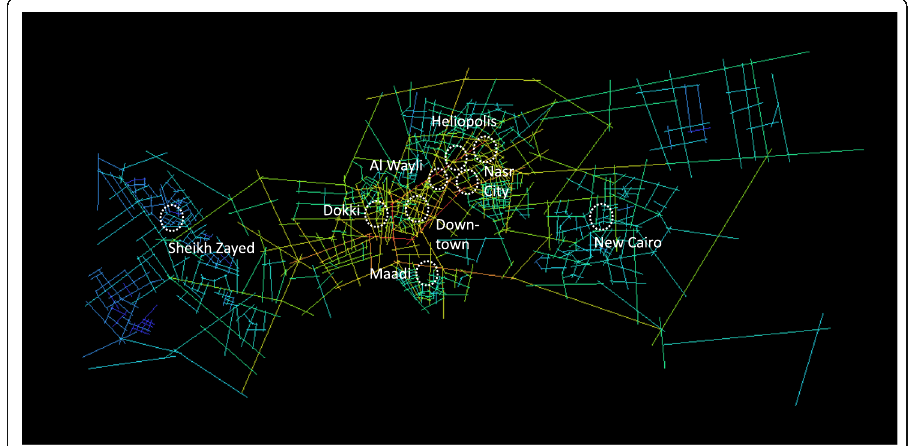
Fig. 8 Space syntax integration analysis ( Rn ); representing the expansion of co-working spaces till 2017, and the spatial segregation of new areas from 2015; red color indicates higher values of integration; blue color indicates segregation and lower values. Elaboration by authors